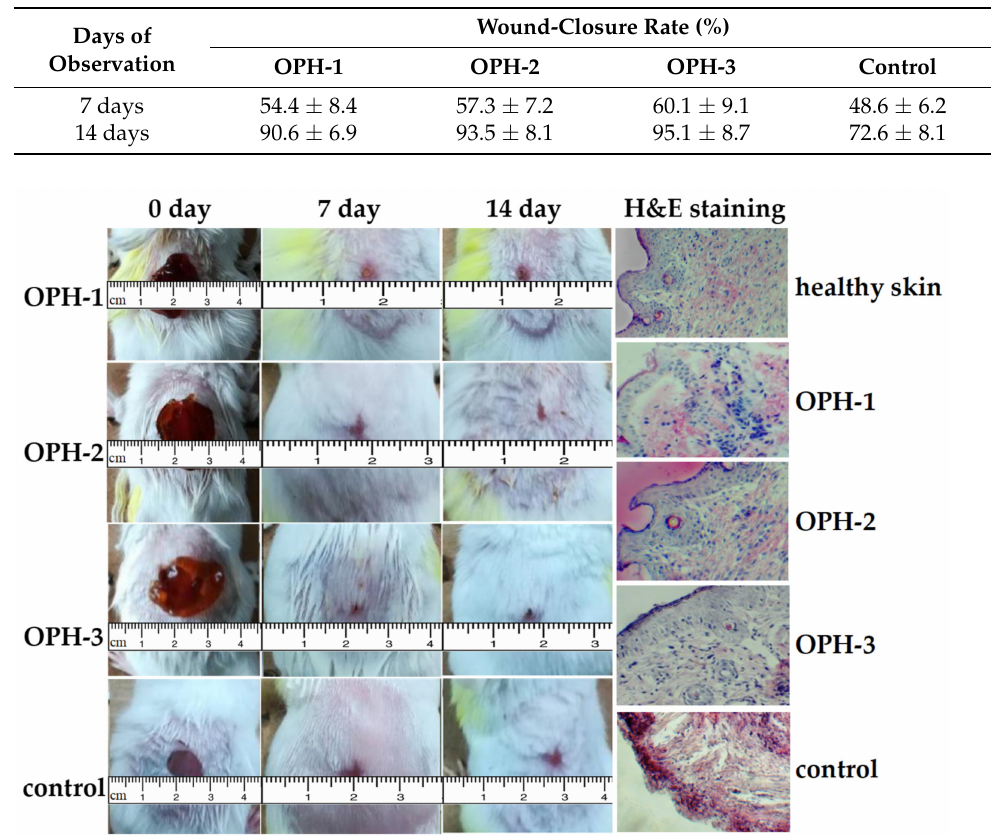
Table 1. Wound-closure rate at 7th and 14th day (mean ± SD, n = 10).